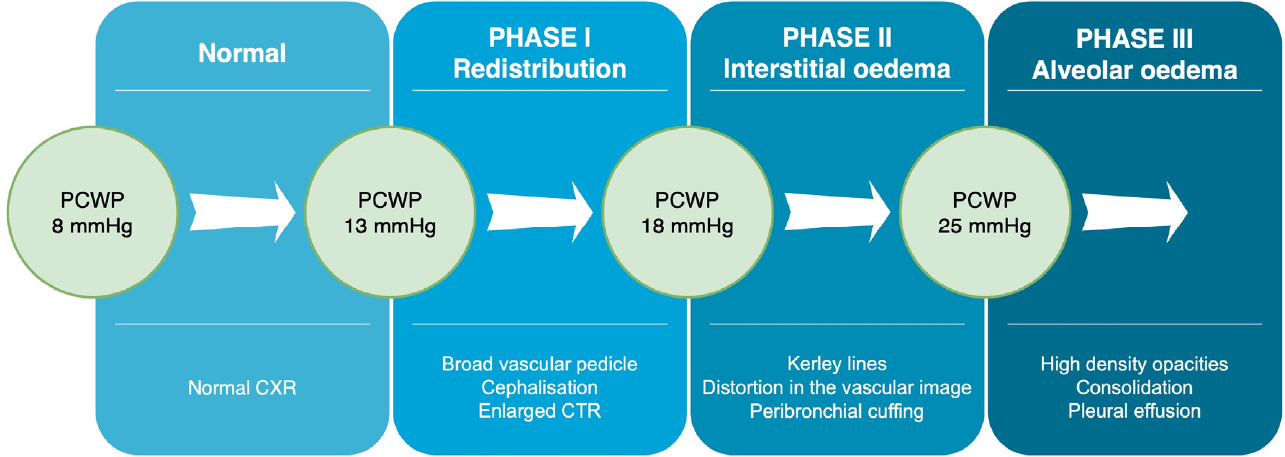
Figure 1. Consecutive phases of HF according to the pulmonary capillary wedge pressure (PCWP). Various pulmonary findings in CXR have been mentioned. CTR—Cardiac thoracic ratio; CXR—Chest X-ray.